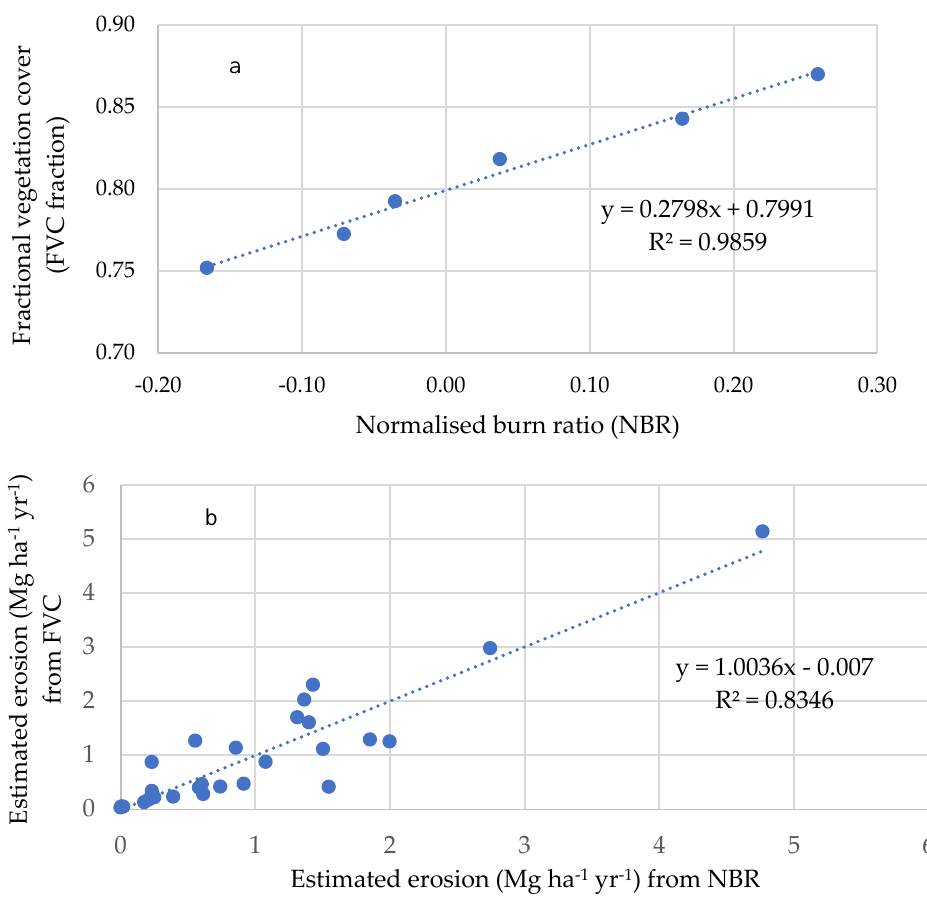
Figure 8. Relationships of fractional vegetation cover (FVC) estimated from MODIS and normalized burn ration (NBR) from Sentinel-2: ( a ) FVC and NBR relationship; ( b ) estimated erosion rates using FVC and NBR.